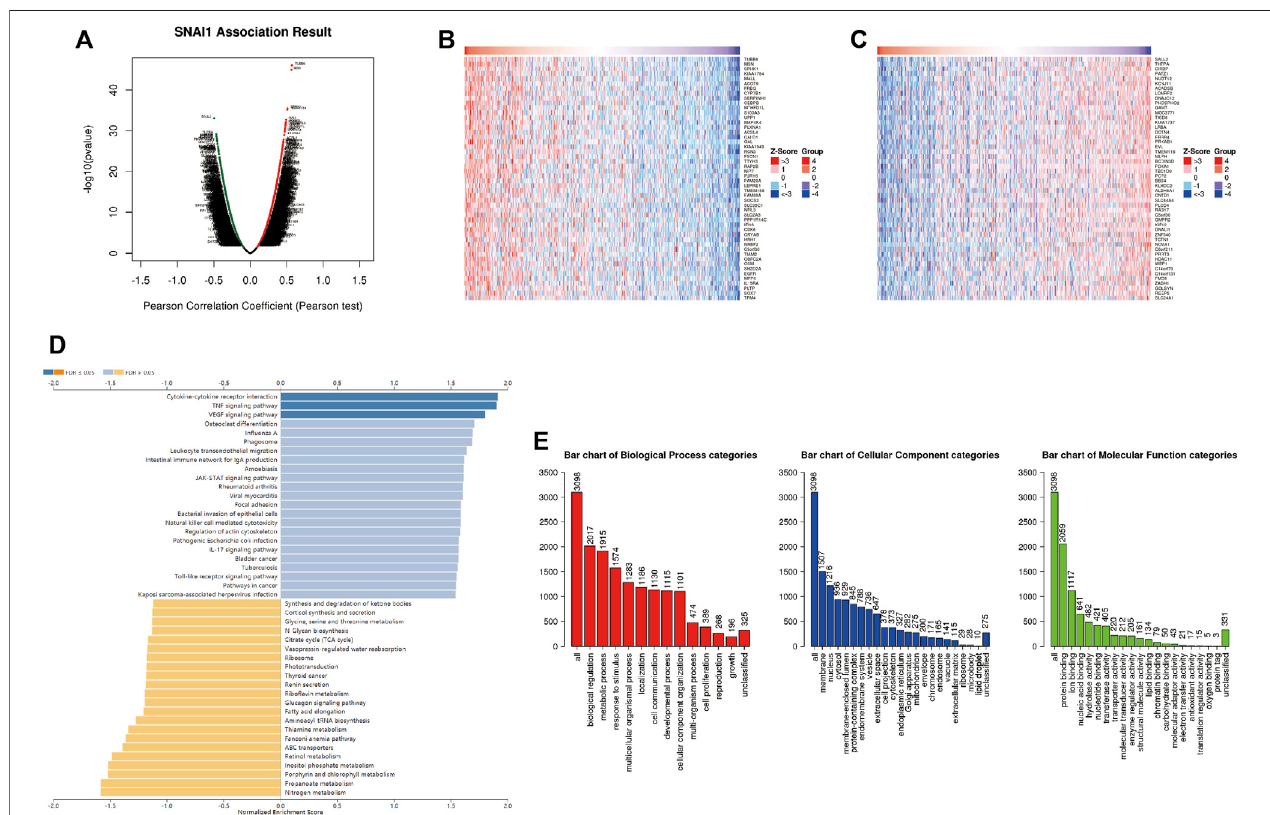
FIGURE4| Analysisofdifferentiallyexpressedgenes(DEGs)incorrelationwithSNAI1inbreastcancer (A) Volcanoplotshowingtheup-anddownregulatedgenes correlated with SNAI1 expression (Pearson test). Signi fi cantly positively correlated (B) and negatively correlated (C) genes are shown in heatmaps (D) Kyoto EncyclopediaGenesandGenomes(KEGG)pathway analysisofthesigni fi cantDEGsincorrelation withSNAI1 (E) Geneontology(GO)analysisofthesigni fi cantDEGsin correlation with SNAI1.